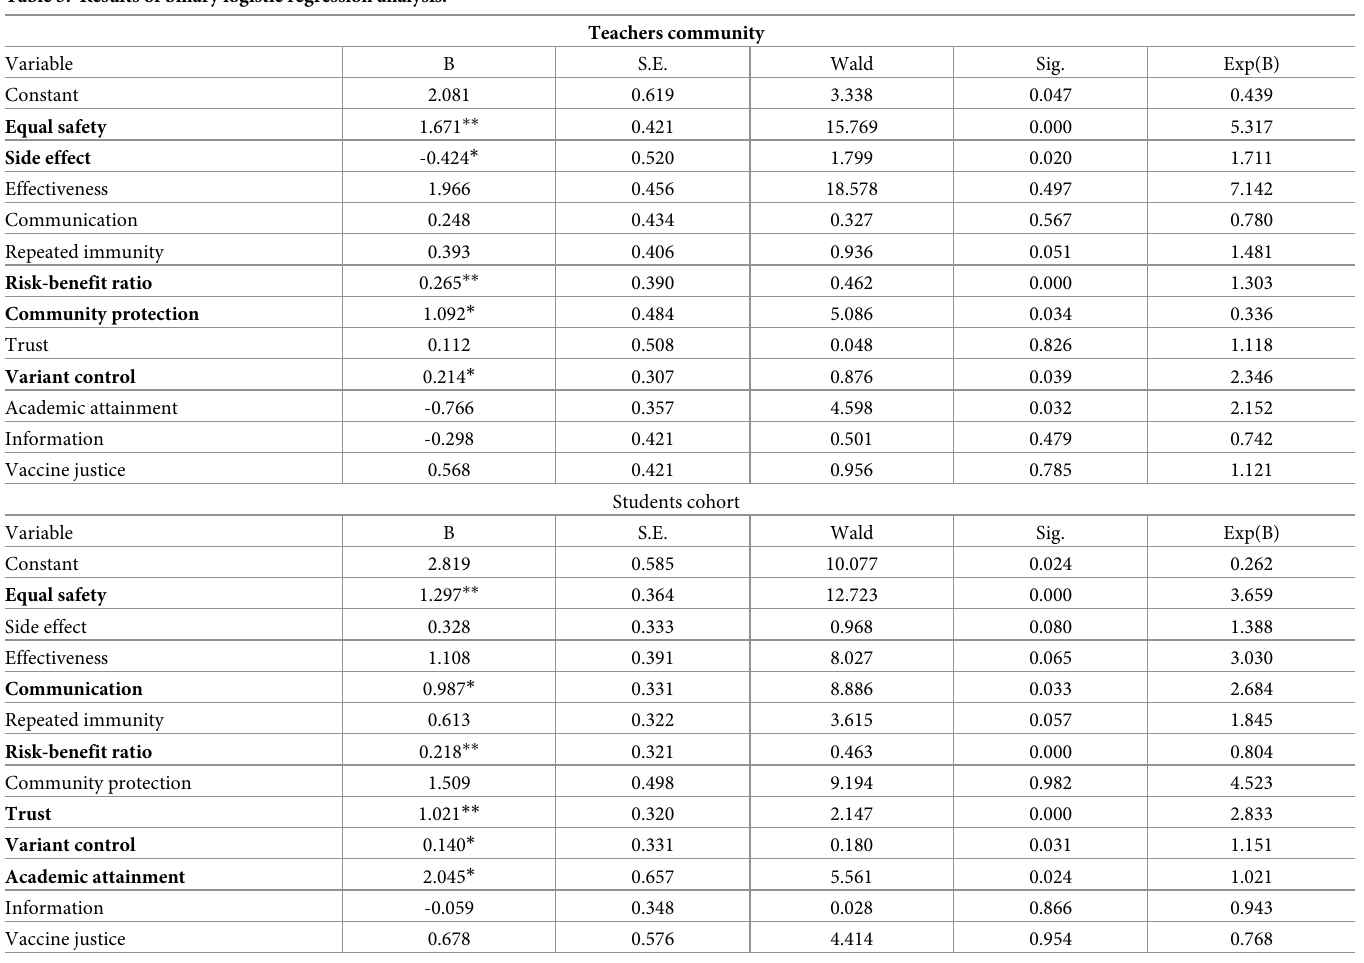
Table 5. Results of binary logistic regression